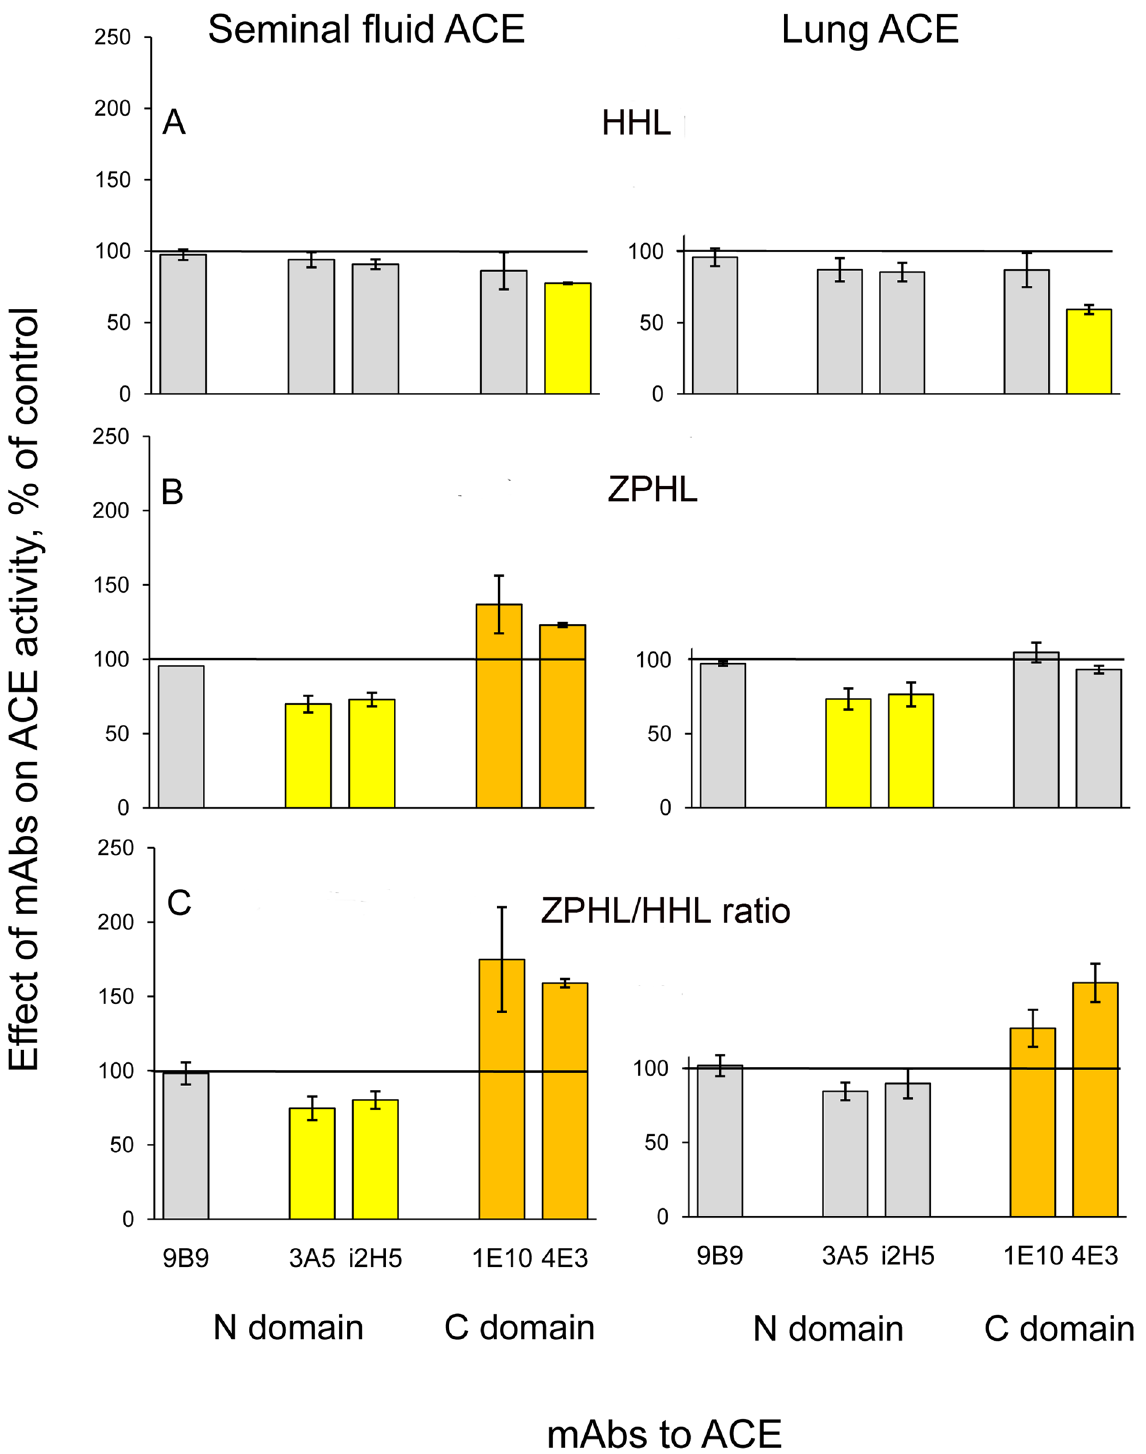
Fig 4. Effect of anti-catalytic mAbs on the activity of pure seminal fluid and lung ACEs. Pure seminal fluid and lung ACEs (5 mU/ml with ZPHL as a substrate) were incubated with mAbs (10 ug/ml), which are anti-catalytic for the N-domain active center, i2H5 and 3A5 [ 27], and for the C domain active center, 1E10 and 4E3 [30], of ACE. Residual ACE activity was determined with substrates HHL ( A ) and ZPHL ( B ) and is presented as the ratio of ACE activity in the presence of mAbs to that without mAbs. Data are also presented as ZPHL/HHL ratio of ACE activity in the presence of mAbs to that without mAbs ( C ). Results are the mean ± SD of 2 – 4 experiments, made in